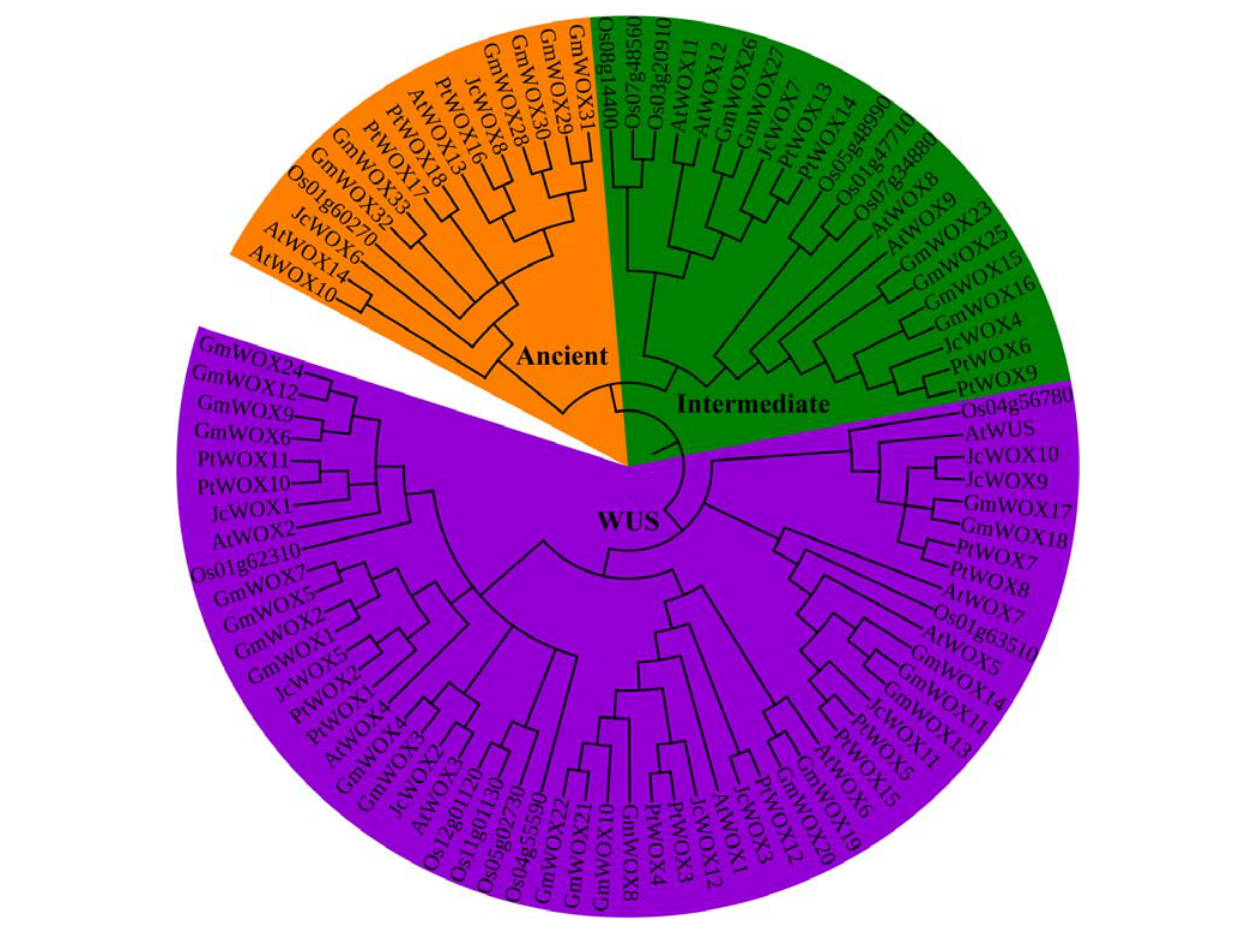
FIGURE 1 | Neighbor-joining unrooted tree of WOX proteins from physic nut, poplar, soybean, and Arabidopsis . Bootstrap values were calculated for 1000 replicates, and values are indicated at the corresponding nodes. Different clade genes were marked and grouped in different colors (ancient clade, intermediate clade, and WUS clade was labeled in orange, green, and purple, respectively).